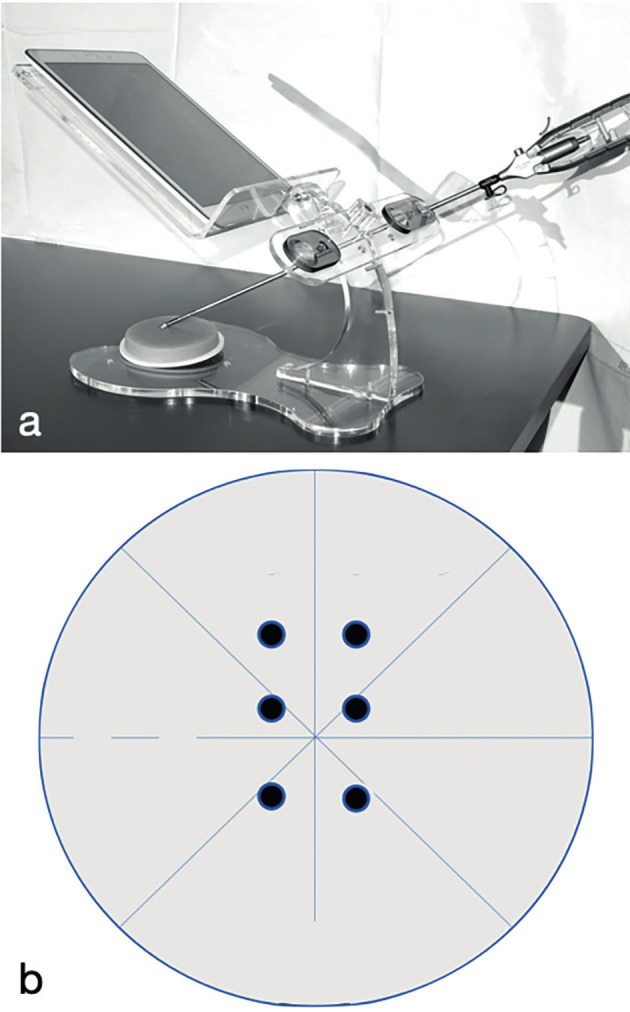
— a) the figure shows the pelvic trainer used for the 1 day course; b) example of the exercise performed by the participants as pre and post-test.